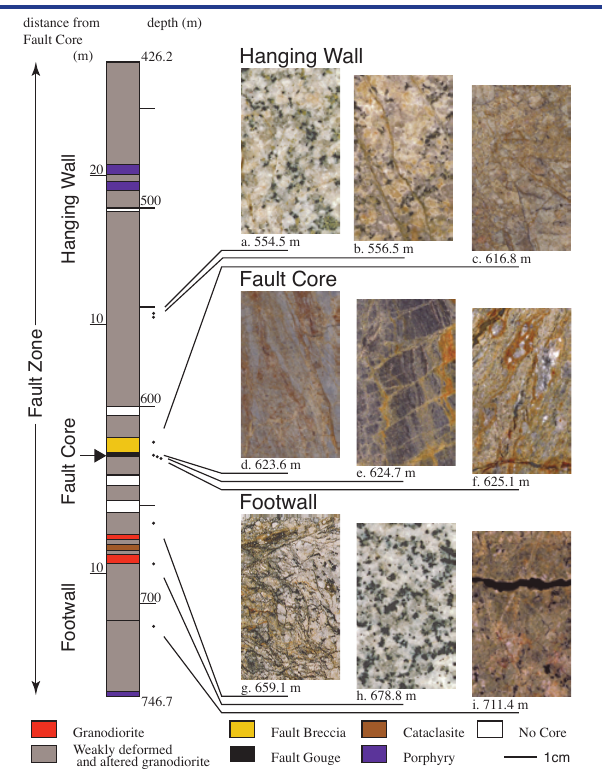
Figure 4. Fault zone structure of the Nojima fault. Hanging wall: Intensity of minor shear zones and the content of brown feldspar increase, and the mafic mineral content decreases toward the fault core. Fault core: Note three types of fault gouge. Footwall: These rocks are much less intensely deformed and altered than in hanging wall (Modified from Ohtani et al.,